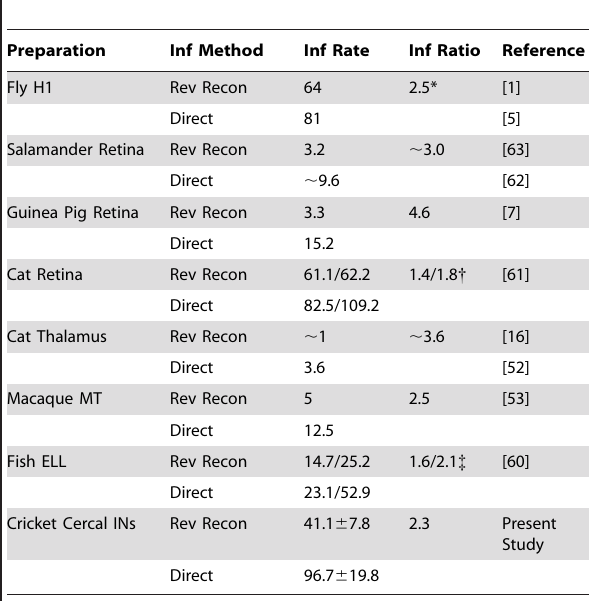
Table 2. Comparison of linear and direct estimates of information rates in various sensory